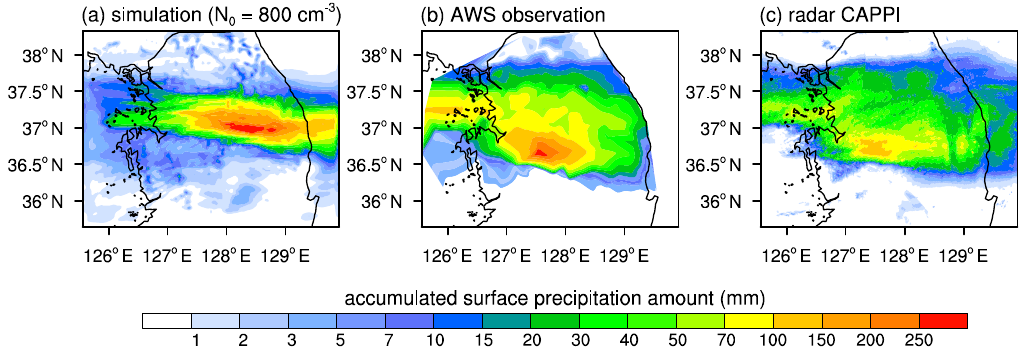
Figure 4. ( a ) Simulated (the N 0 = 800 cm − 3 case) and ( b ) observed (automatic weather systems (AWSs) operated by the Korea Meteorological Administration (KMA)) surface precipitation amounts accumulated over the studied 18 h period (21 LST 15 July–15 LST 16 July 2017). ( c ) Estimated surface precipitation amount accumulated over the 18 h period from 1.5 km constant altitude plan position indicator (CAPPI) data provided by the KMA.